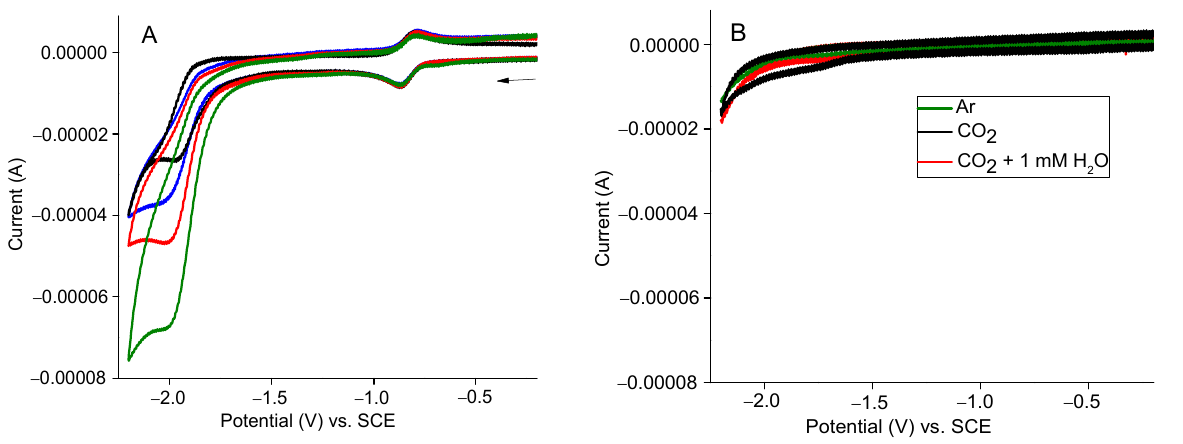
Figure 6. Cyclic voltammograms of 1 mM solutions of [Co(TMFPP)] in 0.1 M n Bu 4 NBF 4 /DMF in the presence of H 2 O (Black: in Ar, Red: in CO 2 , Blue: in Ar and 1 mM of H 2 O and green: in CO 2 and 1mM of H 2 O) ( A ). Blank test without catalyst ( B ).